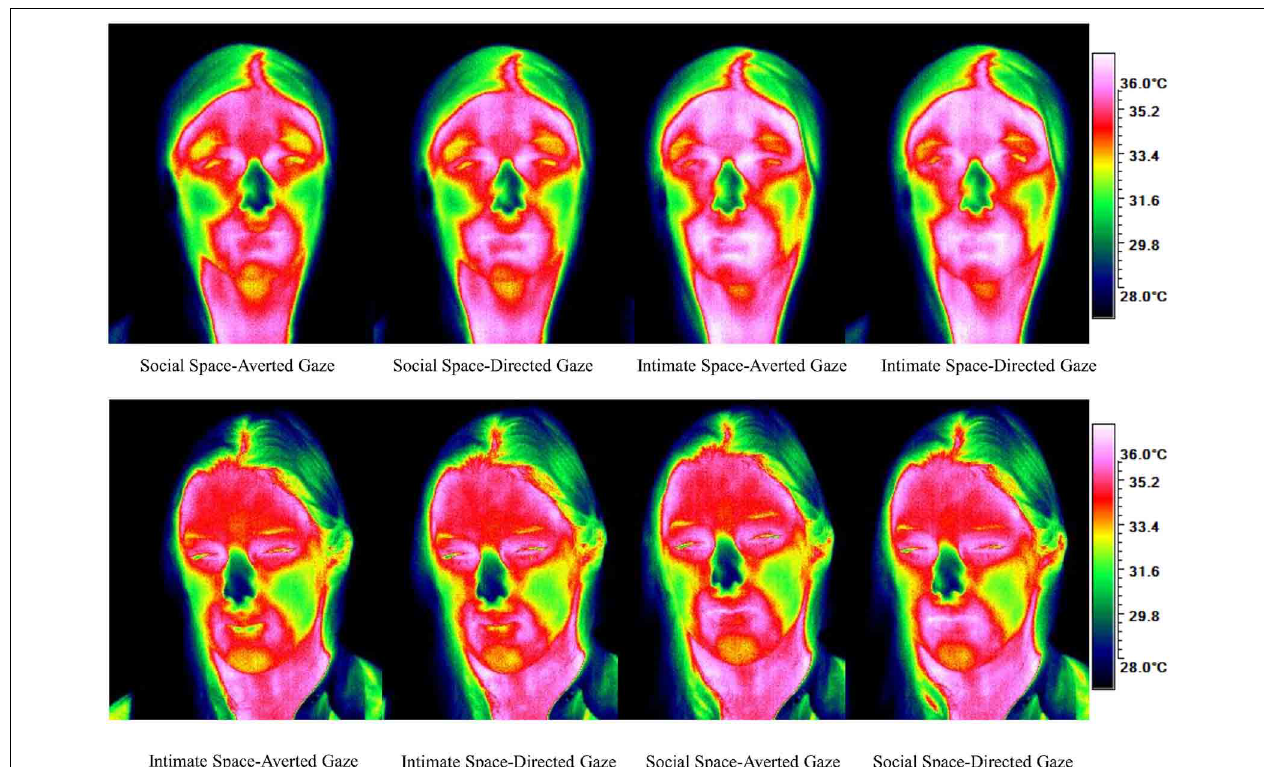
FIGURE 4 | Visual illustration of the development of temperature for each condition according to